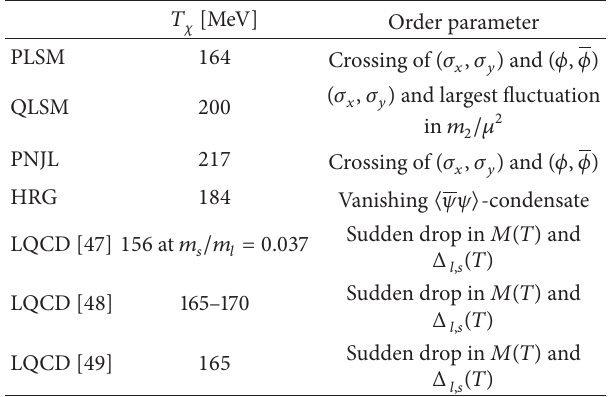
Table 2: The pseudocritical temperatures 𝑇 𝜒 as calculated from PLSM, QLSM, PNJL, and HRG and the different sets of lattice QCD calculations.